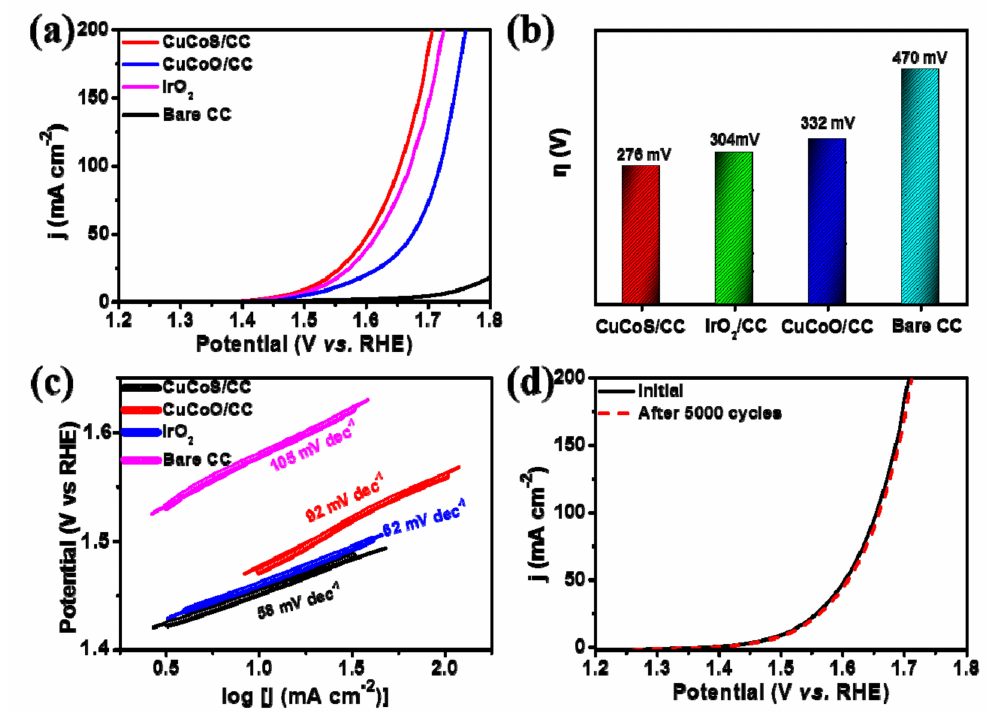
Figure 3. ( a ) Polarization curves, ( b ) Comparisons of the potentials required to reach the current density of 10 mA cm − 2 , ( c ) Tafel plots of various catalysts in 1.0 M KOH solution at 5 mV s − 1 of CuCoS / CC, CuCoO / CC, bare CC and IrO 2 / CC. ( d ) Linear sweep voltammetry (LSV) curves after 5000 CV cycles for the CuCoS / CC electrode.